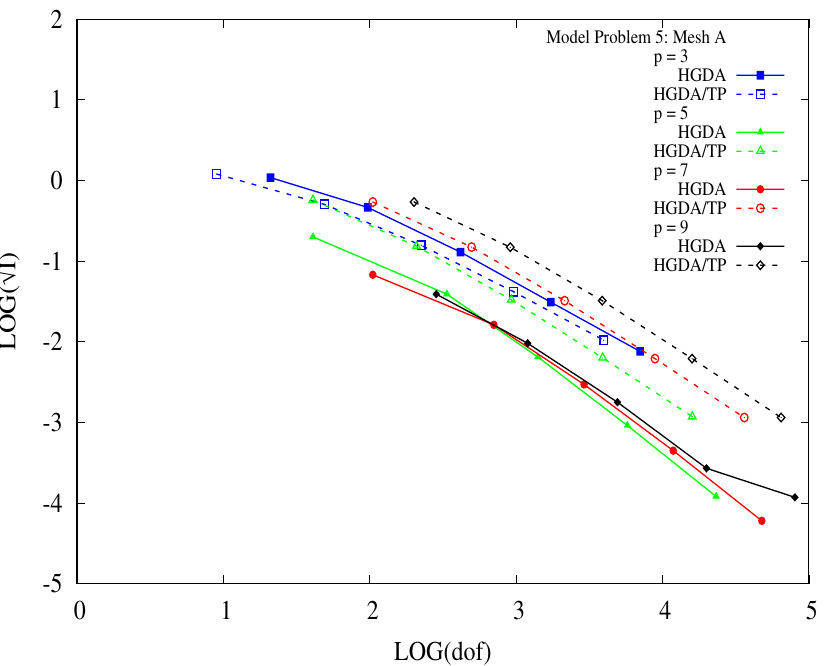
Figure 22. Residual function I versus dof, C 11 solutions: Model Problem 5 (Convection Diffusion Equation; Mesh A; HGDA/DG and HGDA/TP).